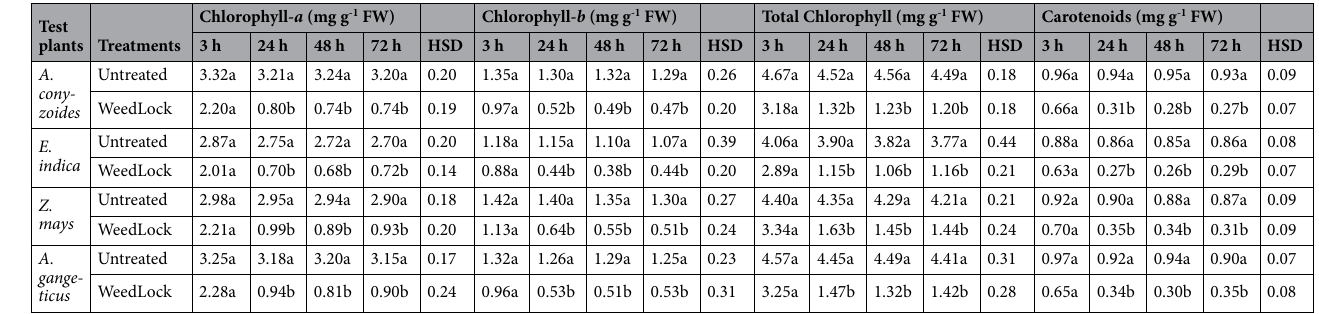
Table 2. Effect of WeedLock on pigment content of test plants. Means having different letters differ significantly at p <